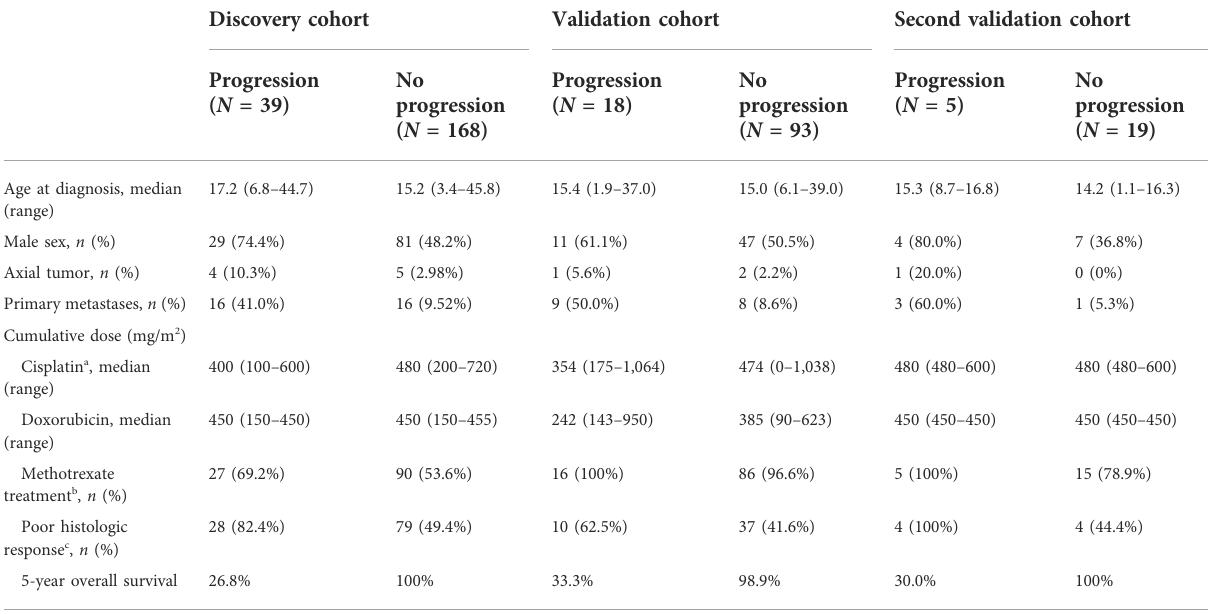
TABLE 1 Clinical characteristics of the osteosarcoma patients of the discovery and validation